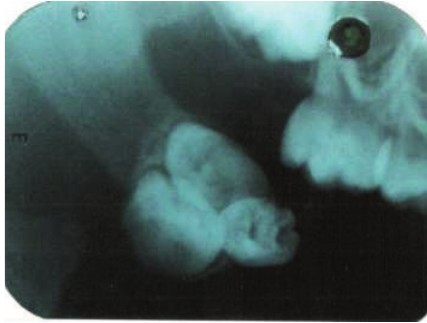
Figure 2: Intraoral periapical radiograph showing three radiopaque tooth-like masses with a radiolucent rim.